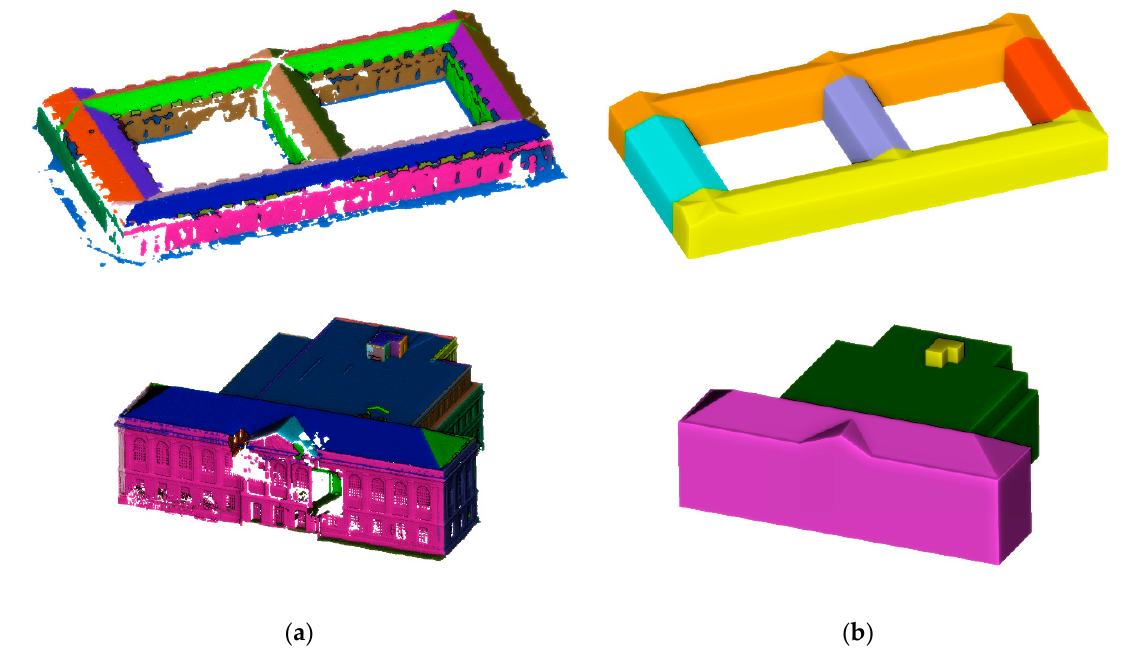
Figure 11. Building components analyses of two example buildings based on the CSG-BRep trees. ( a ) Planar segments extracted from building point clouds using RANSAC; ( b ) Generated building models with multiple parts (coded by different colors) determined using the CSG-BRep trees.